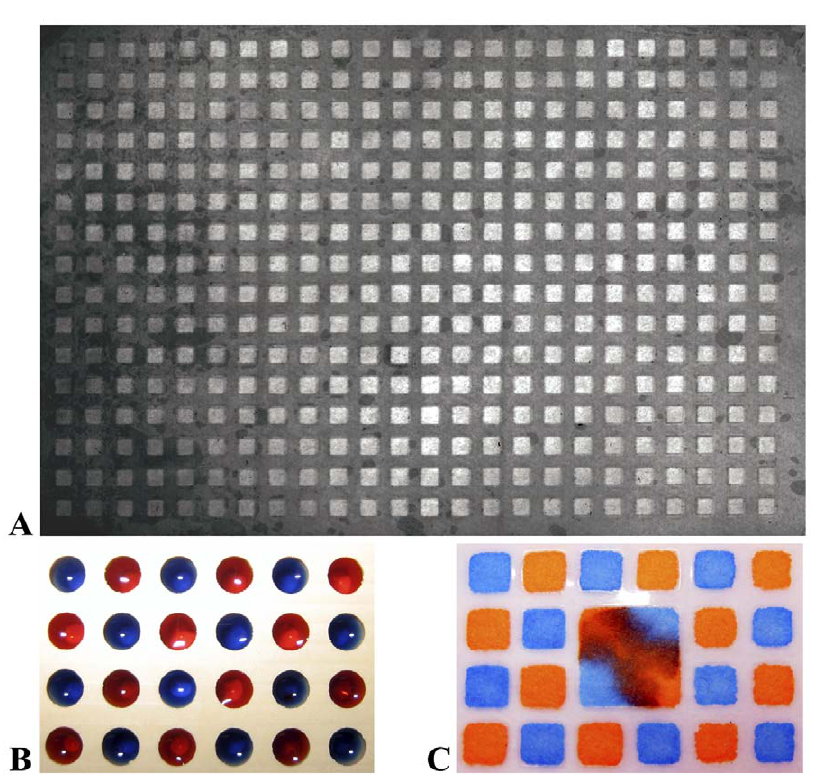
Figure 2. Anion-exchange chemistry arrays. ( A ) A cellulose filter patterned with photocurable fluoropolymer. ( B ) The filter clamped between the two plates of the chemistry apparatus. The wells are filled in a checkerboard pattern with solutions of Orange G and xylene cyanol. ( C ) After evacuating the dye solutions and washing on a vacuum manifold, the filter is removed from the chemistry apparatus. The dyes mix only in the central squares, which lack fluoropolymer barriers between neighboring wells.